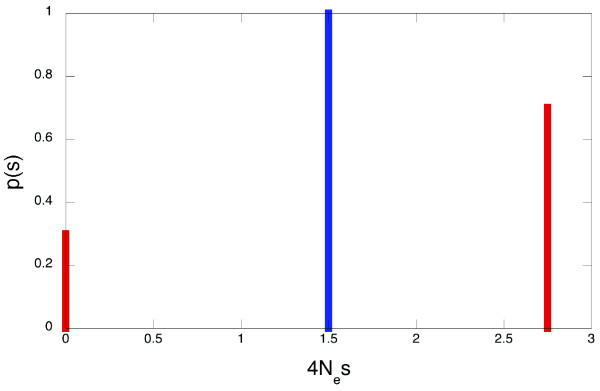
Distributions of selection coefficients with extremal properties. Distributions p(s) that correspond to the minimal average selection coefficient (blue line) and to the maximal fraction of selectively neutral sites (red lines), as long as the average rate of parallel evolution P constitutes 0.7 of the rate of neutral evolution. Vertical lines denote delta functions.